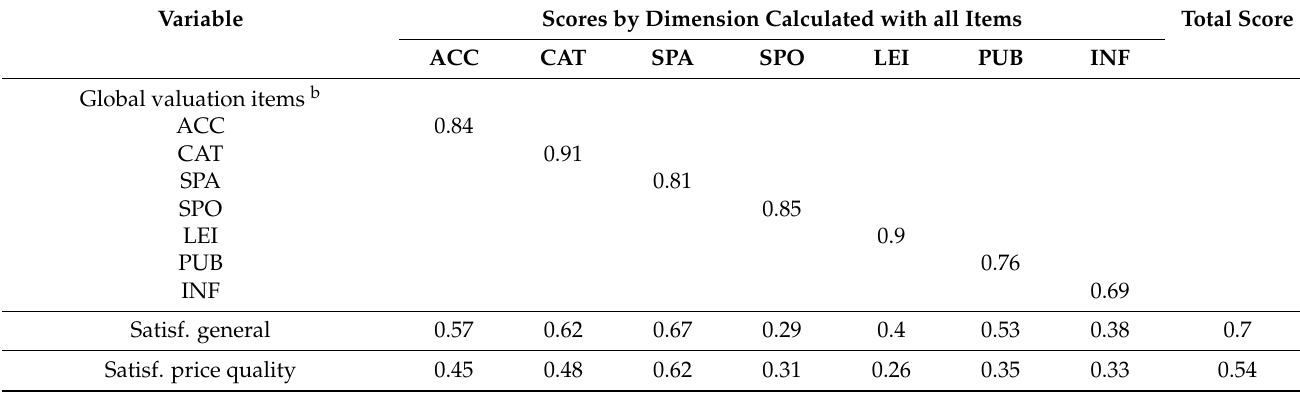
Table 9. Construct validity: association (Pearson correlation) a between global assessment by dimension, general satisfaction and score of the main questionnaire ( n =